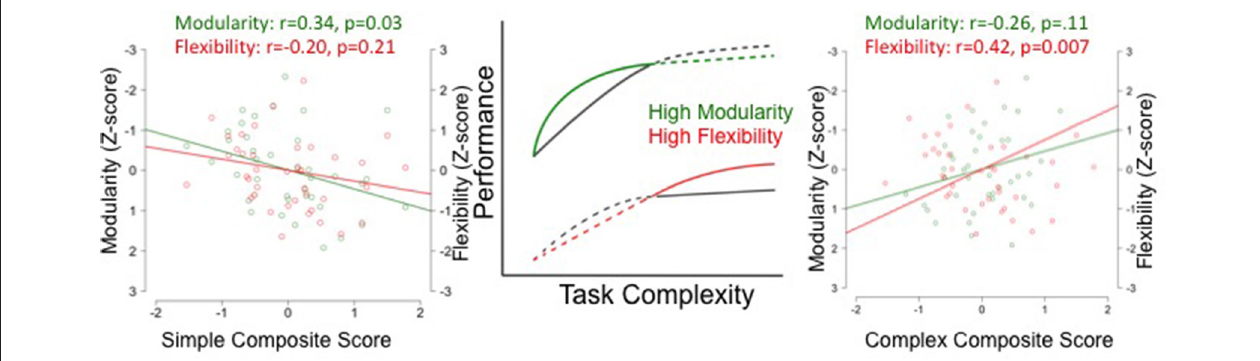
FIGURE 3 | Modularity and Flexibility predict different performance during simple and complex tasks. The two graphs on the left and right illustrate the relationship between simple and complex composite scores (calculated by summing the z-scores for the performance measures for the simple and complex tasks) and modularity (green) and flexibility (red). This relationship is represented by the magnitude of the coefficient between modularity and task performance and flexibility and task performance for simple (left) and complex (right) . The center of the figure depicts the theoretical prediction relating performance to task complexity for individuals with high and low modularity (green curve) and flexibility (red